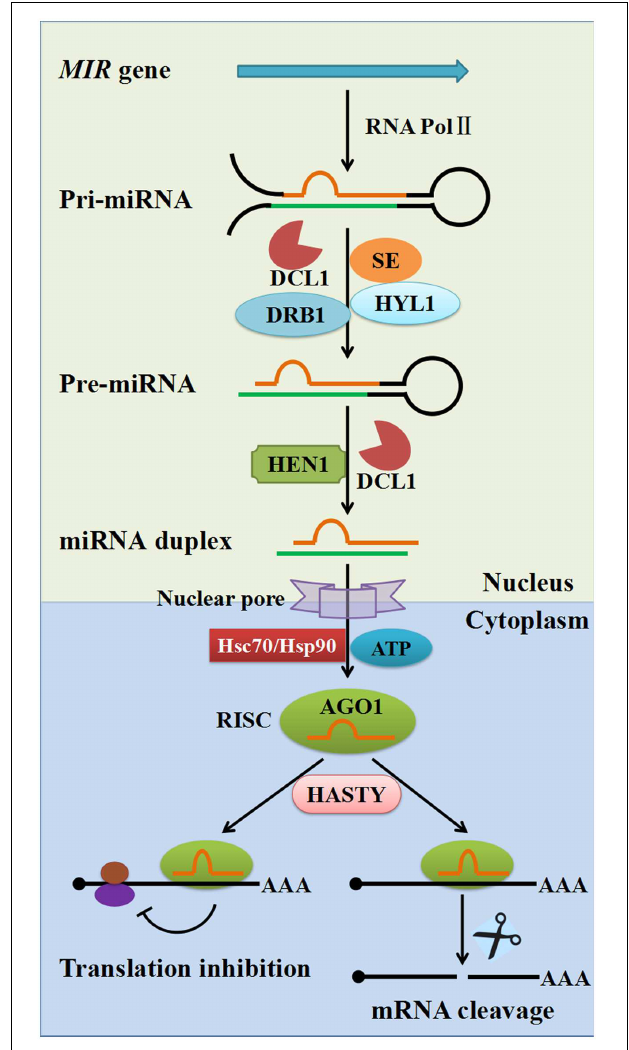
FIGURE 1 | The biogenesis and regulation mechanisms of plant miRNAs. Plant pri-miRNAs are mostly produced from MIR genes by RNA polymerase II (Pol II). Pri-miRNAs are cleaved into pre-miRNAs by DCL1 with the assistance of SE, dsRBP and HYL1. Pre-miRNAs are further processed into 21–24 nucleotide duplex miRNAs by the combined action of DCL1 and HEN1. Duplex miRNAs are methylated by HEN1 into mature miRNA duplexes and are exported to the cytoplasm through the action of plant exportin 5 ortholog HASTY. The guide-strand (red) is then loaded onto an AGO protein with the help of Hsc70/Hsp90 chaperone and ATP, followed by passenger strand (green) ejection, to form a RISC. There are two modes of plant miRNA action in cytoplasm: in one, the miRNA regulates its target at the protein level through translational inhibition (left); in the other, the miRNA regulates its target at the mRNA level through mRNA cleavage (right). AGO1, Argonaute 1; DCL1, Dicer-like1; SE, Serrate; HEN1, Hua enhancer1; DRB1, Double-strand RNA binding protein1; HYL1, Hyponastic leaves1; RISC, RNA-induced silencing